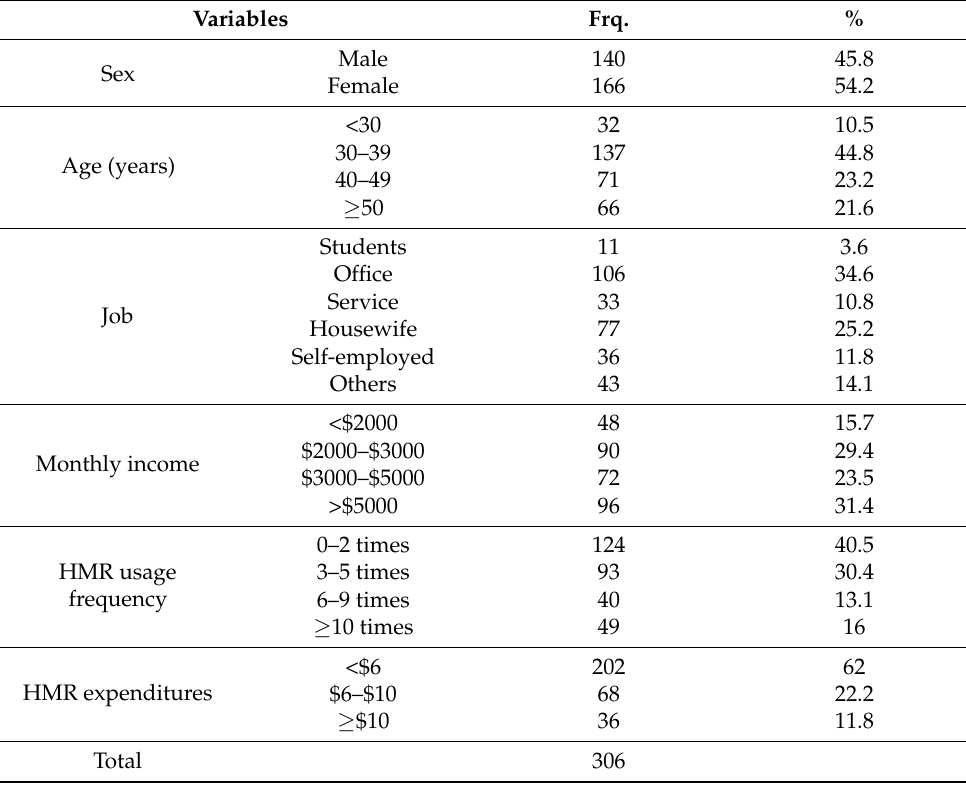
Table 3. Demographics and consumption characteristics of the